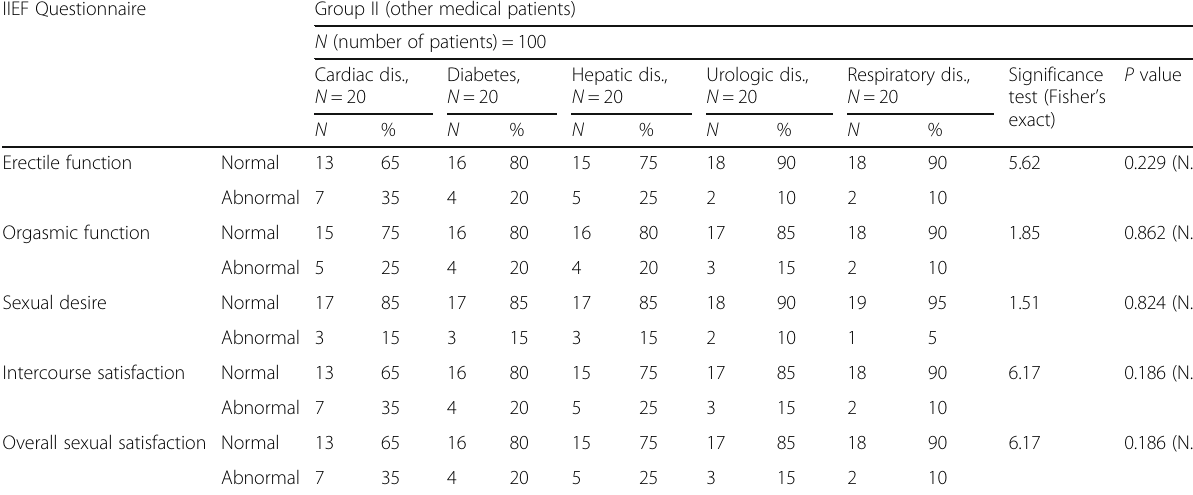
Table 7 Patterns of sexual functions among patients of group II (other medical patients) IIEF Questionnaire